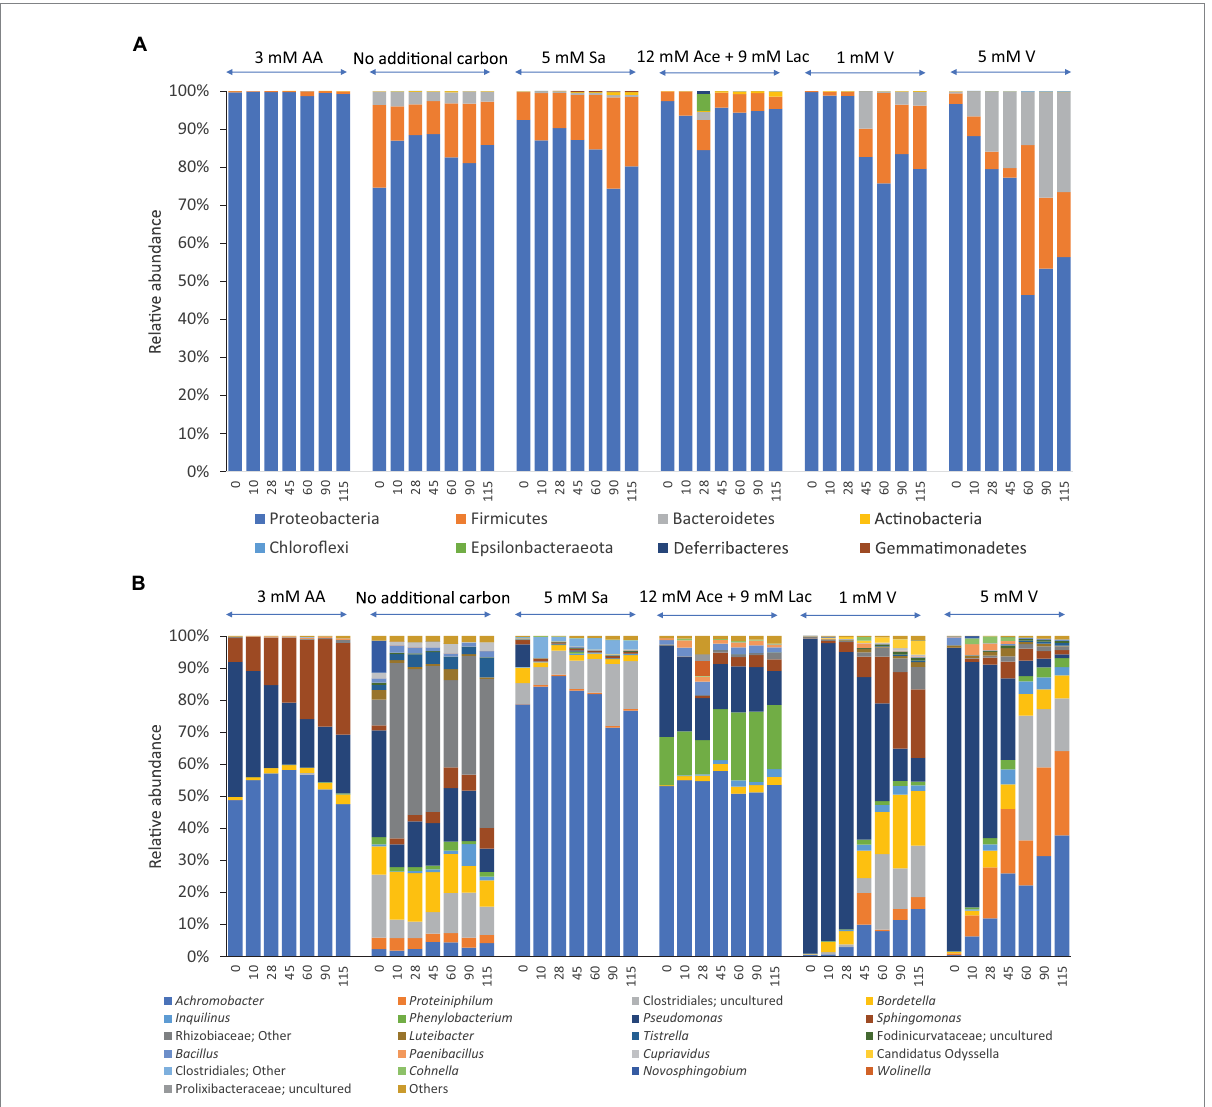
FIGURE 3 Relative abundance of bacteria at the phylum level (A) and genus (or higher) level (B) of enrichments with different carbon and energy sources and 2,3,7,8-TCDD in 7 mM DMSO during 115 days of incubation. The sources were 3 mM aromatic amino acids (3 mM AA), no additional carbon and energy sources, 5 mM sodium salicylate (5 mM Sa), a mixture of 12 mM sodium acetate and 9 mM sodium lactate (12 mM Ace+9 mM Lac), 1 mM vanillin (1 mM V), 5 mM vanillin (5 mM V). The data shown are the averages of two replicates. Genera with relative abundances less than 2% are grouped as